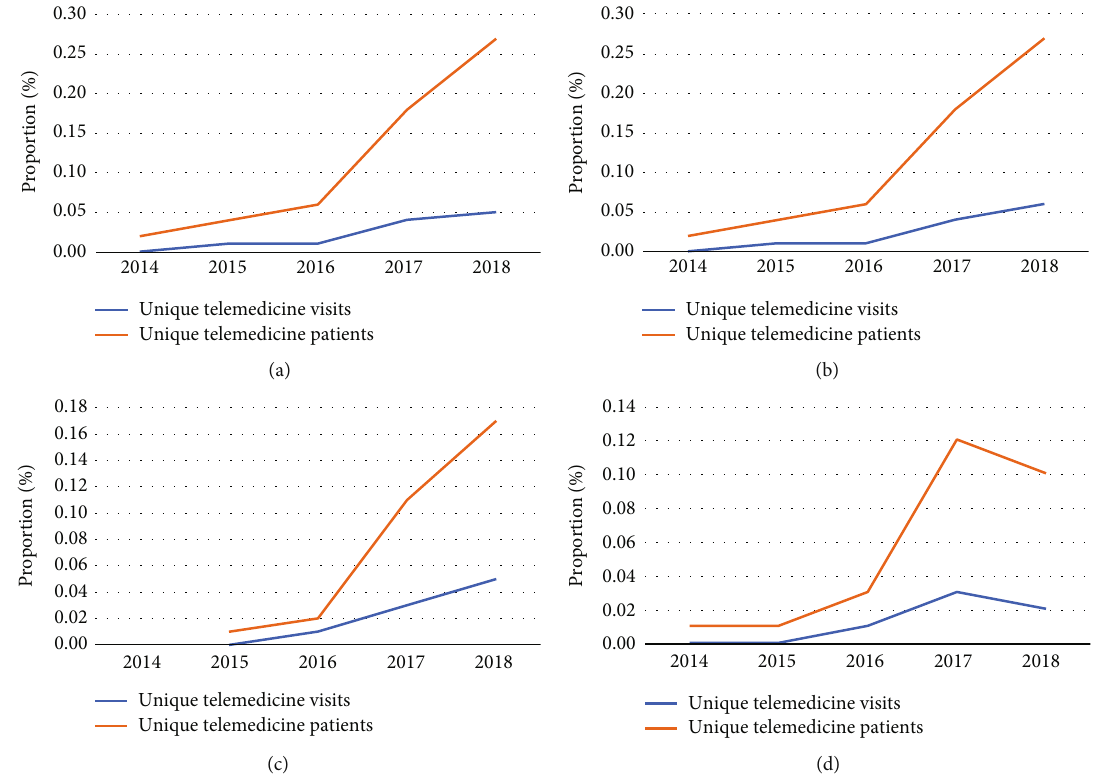
Figure 1: Trends in unique telemedicine visits/patients for (a) all adults ( > 18) with MDC code 8, (b) with only low back or neck pain, (c) with only hip/knee pain, and (d) musculoskeletal